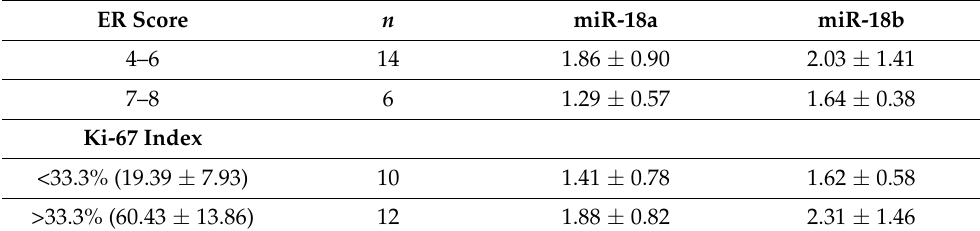
Table 4. Expression levels of miRNAs in CMTs based on ERα immunoexpression and Ki67 index. Data are presented as mean ± SD. Gene expression levels are intended as fold change normalized to endogenous controls using Formula 2 ∆∆ Cq .